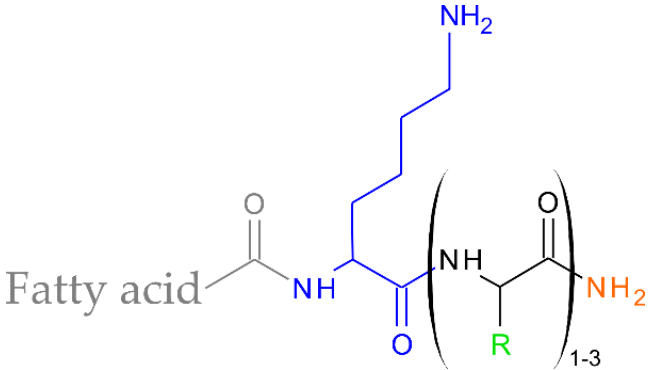
Figure 1. General structure of lipopeptides.